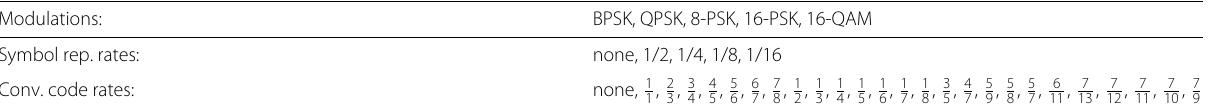
Table 1 The list of options for the modulation, symbol repetition, and convolutional code rates from which the optimization can select